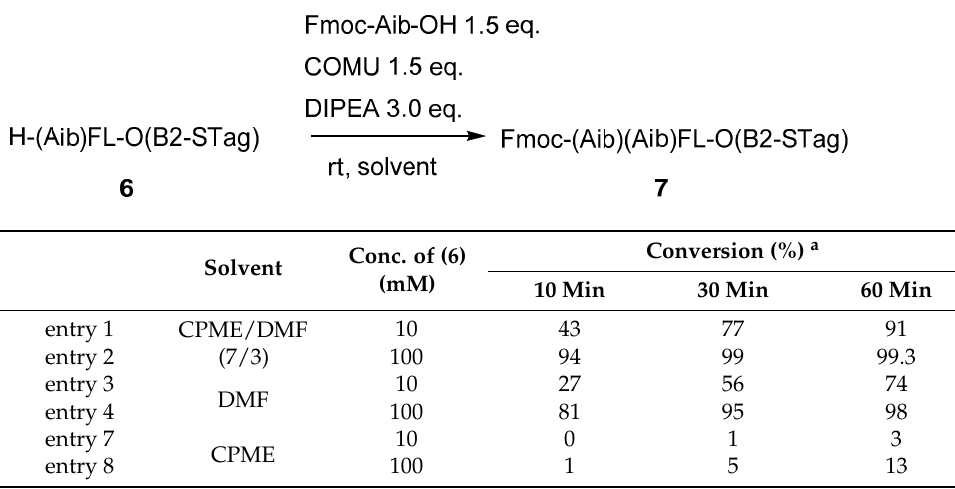
Table 2. Kinetics of the coupling reaction of a STagged peptide.